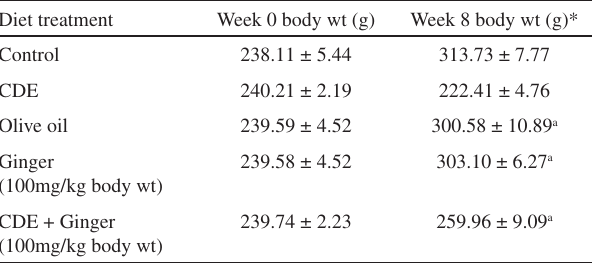
Table 2 - Weight of rats with different diet treatment Diet treatment